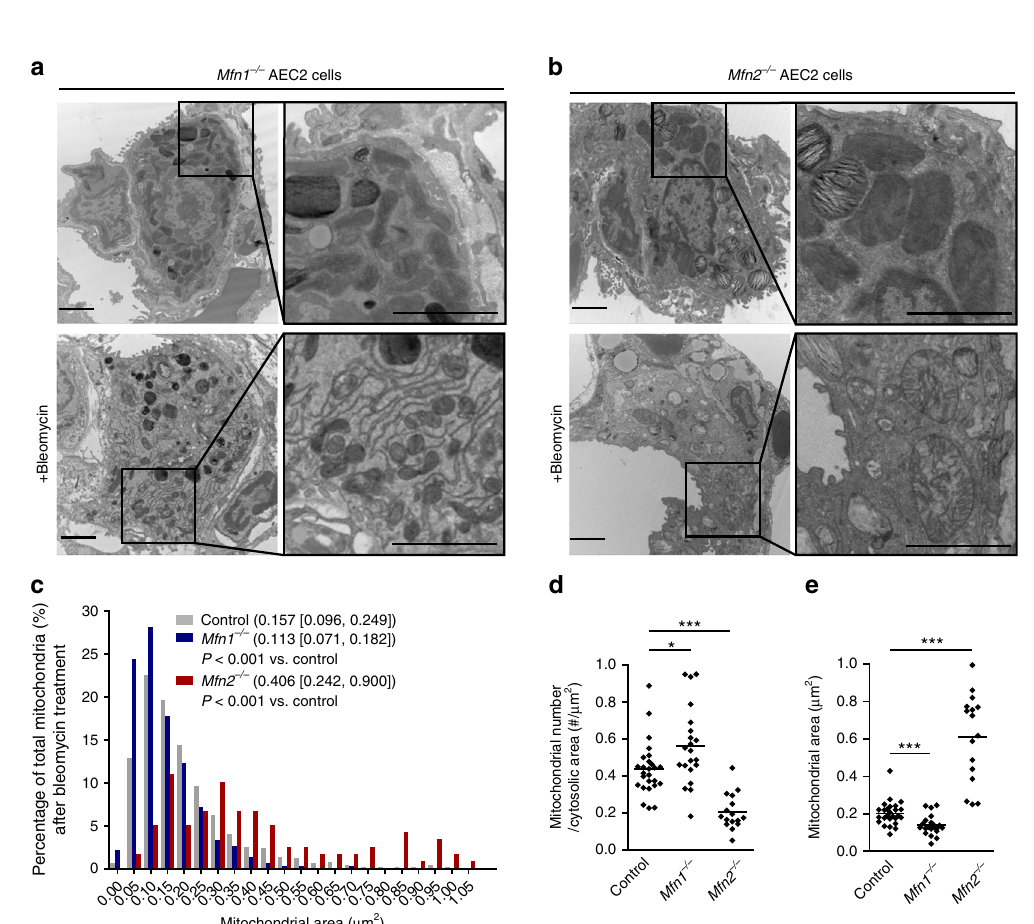
Fig. 2 Mice with AEC2 cell-speci fi c deletion of Mfn1 or Mfn2 . a Schema demonstrating the generation of AEC2 cell-speci fi c mice de fi cient in Mfn1 or Mfn2 using a tamoxifen-inducible Sftpc -promoter driven CreERT2. Sftpc CreERT2 + / − mice were used as controls. b Genotyping of DNA extracted from CD45( − ) EpCAM( + ) cells and CD45(-)EpCAM( − ) cells isolated from control and Mfn1 i Δ AEC2 mice 6 weeks after tamoxifen injection ( n = 3 mice per group). c Representative immunoblots of AEC2 cell lysates obtained 3 weeks after tamoxifen-induced deletion, showing decreased protein levels of MFN1 or MFN2 in the respective knockout cells ( n = 3 mice per group). d Representative TEM images (upper row, ×12,000, scale bar 2 μ m; lower row, ×50,000, scale bar 500 nm) show mitochondrial ultrastructural changes in Mfn1 − / − and Mfn2 − / − AEC2 cells ( n = 3 mice per group) with disrupted cristae marked with white arrowheads. e , f Quanti fi cation of ( d ); mitochondrial number per μ m 2 of cytosolic area ( e ) and mitochondrial area ( μ m 2 ) ( f ) in each AEC2 cell, using TEM images (×12,000). Each dot represents one AEC2 cell, and the line indicates mean (control AEC2 cells n = 15, Mfn1 − / − AEC2 cells n = 14; Mfn2 − / − AEC2 cells n = 14, from a total of 3 mice per group; * p < 0.05, ** p < 0.01, *** p < 0.001, vs. control by unpaired Student ’ s t test). g Representative TEM images (×5000) of the bronchial epithelium in control ( Sftpc CreERT2 + / − ), Mfn1 i Δ AEC2 and Mfn2 i Δ AEC2 mice ( n = 3 mice per group; scale bar 5 μ m). h Representative Masson ’ s trichrome-stained sections (×100 magni fi cation) of murine left lung at 28 – 32 weeks post tamoxifen-induced deletion (control